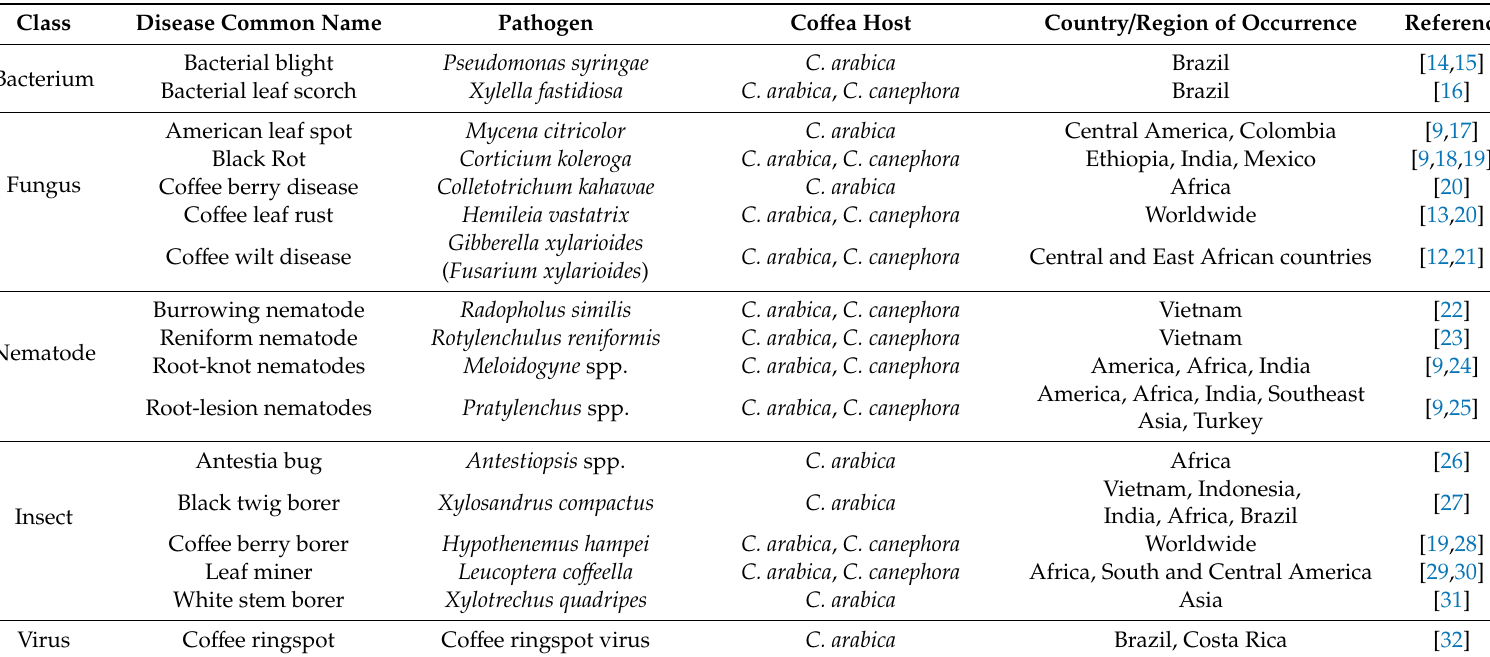
Table 1. List of pathogens and pests commonly present in Co ff ea arabica and / or C.